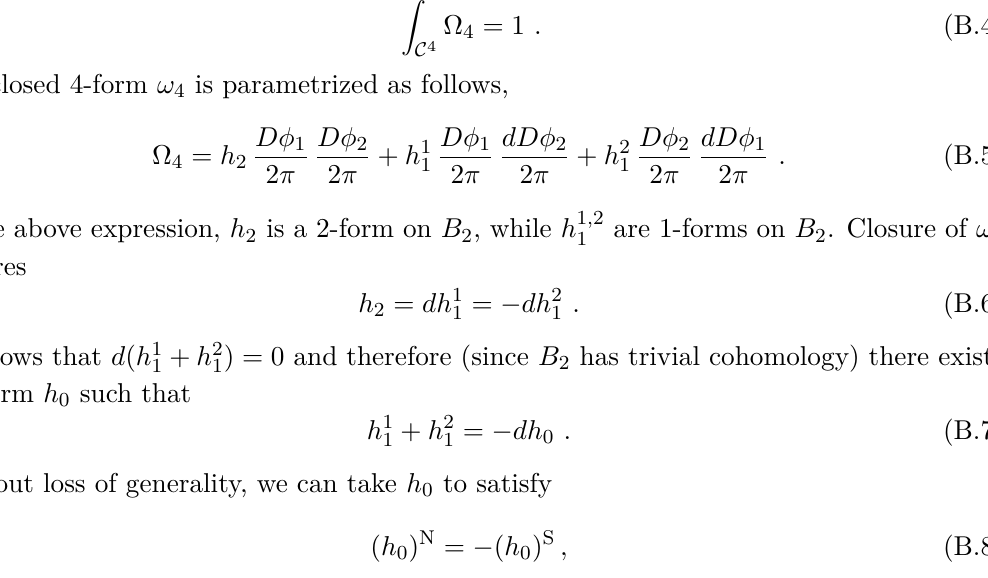
+ dµ 2 + dµ 2 . We have also indicated the orientation of ∂B 0 1 2